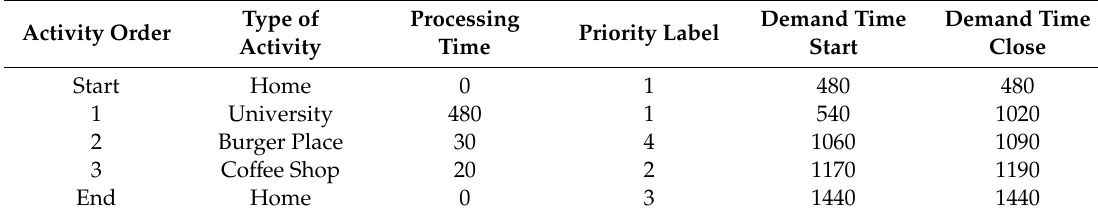
Table 7. Part of the input of the traveler regarding the spatial and temporal aspect of activities.